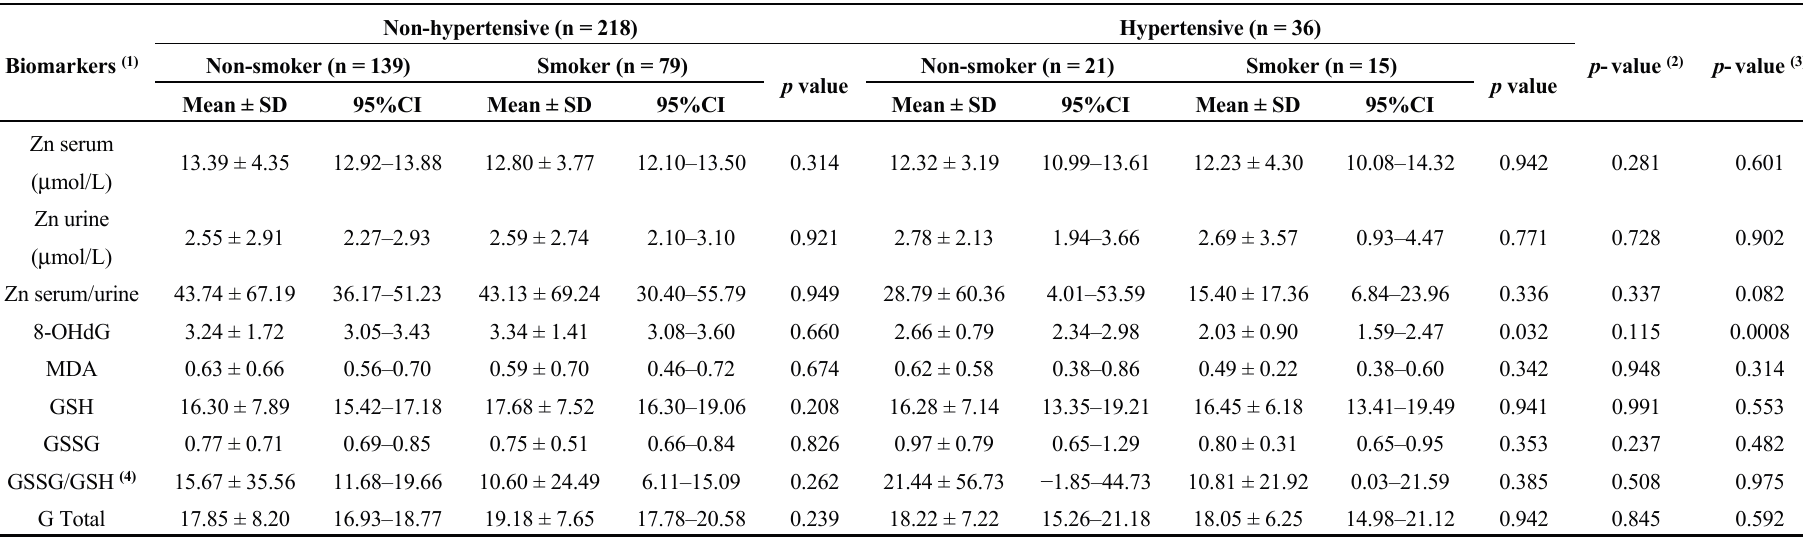
Table 3. Levels of zinc in serum, urine and Zn serum/urine quotients and oxidative stress markers in the study population. Biomarkers